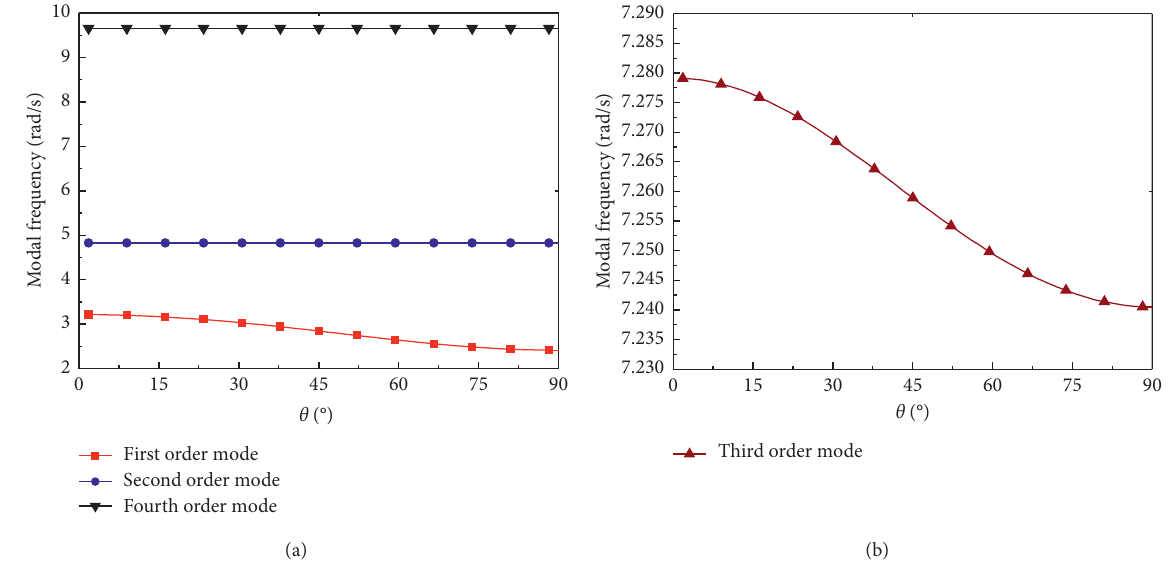
Figure 4: Relationship between in-plane modal frequency and inclination of tether.